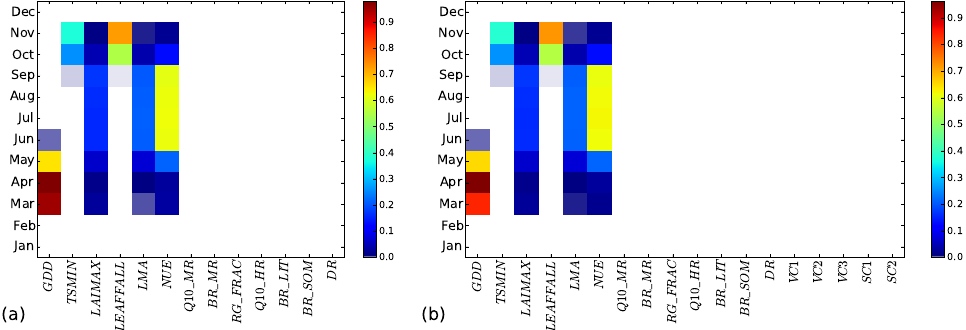
Figure 4. Matrices with total effect Sobol indices, S T to the one in Fig.